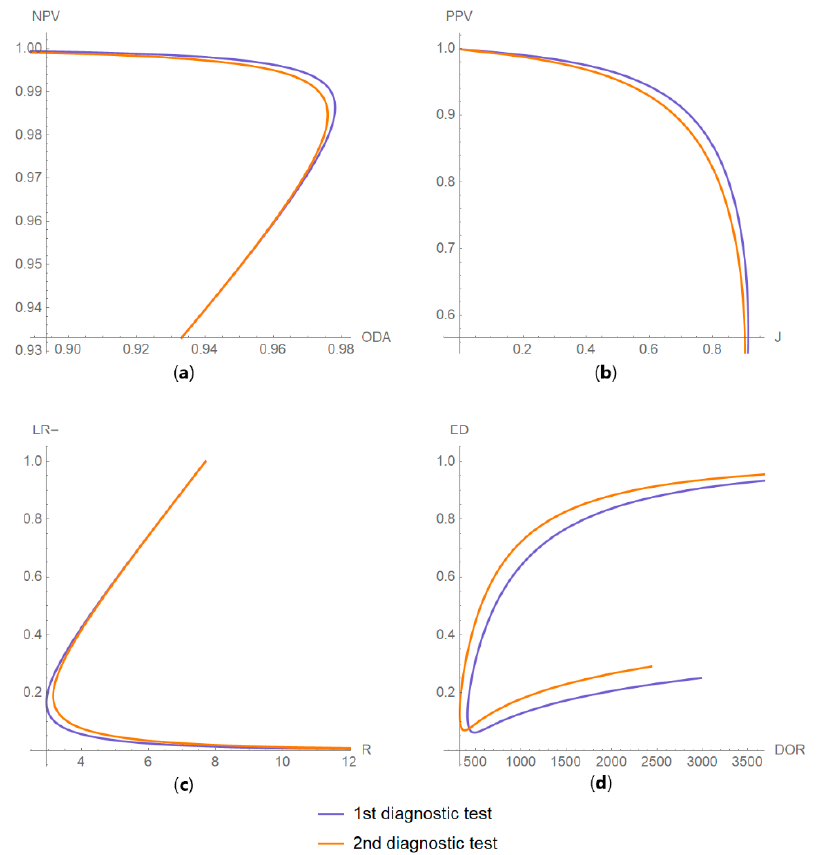
Figure 16. DAM partial derivatives against diagnostic threshold plots. Plots of partial derivatives of ( a ) overall diagnostic accuracy ( ODA ), ( b ) Youden’s index ( J ), ( c ) positive predictive value ( PPV ) and ( d ) risk ( R ), with respect to measurement uncertainty, of two diagnostic or screening tests measuring the same measurand with different uncertainties, against diagnostic threshold ( d ) curves, with the parameters in Table 4.